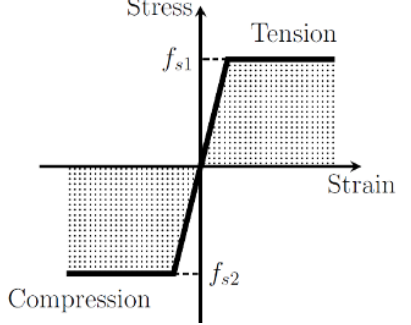
Figure 2. Constitutive law of steel reinforcement.